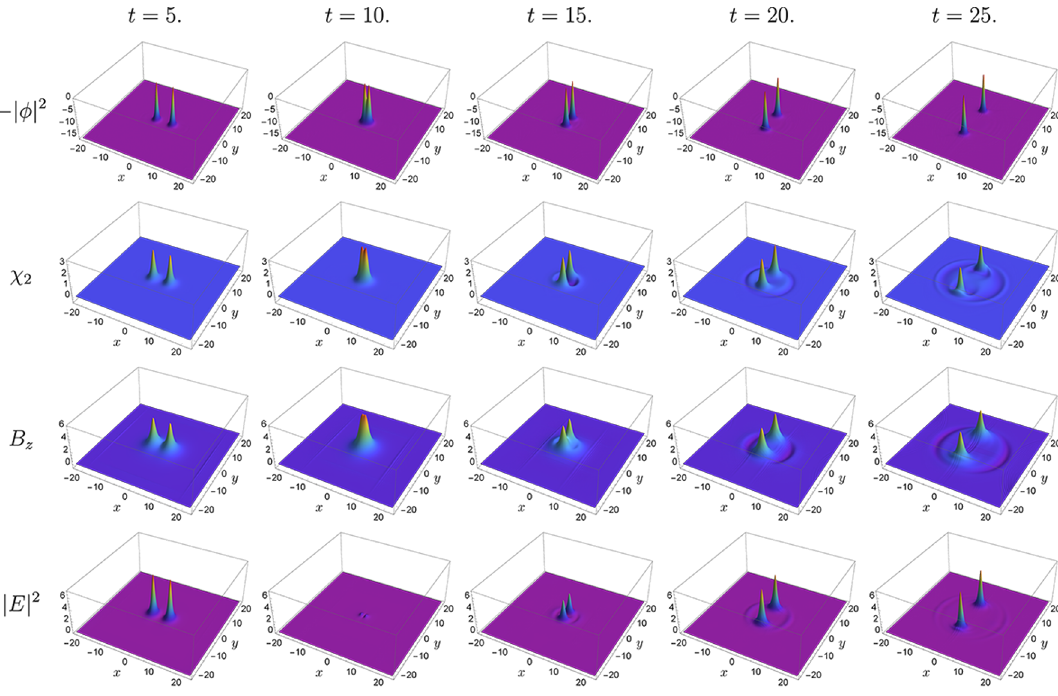
Figure 22 . Snapshots of −| φ | 2 , χ 2 , B z and | E | 2 for head-on collision of type II parallel non-Abelian vortices with initial velocity u = 0 . 6 .